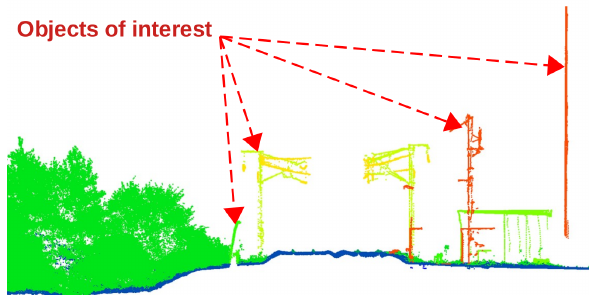
Figure 2. Slice from an aerial LIDAR point cloud of railway tracks colorized by semantic class